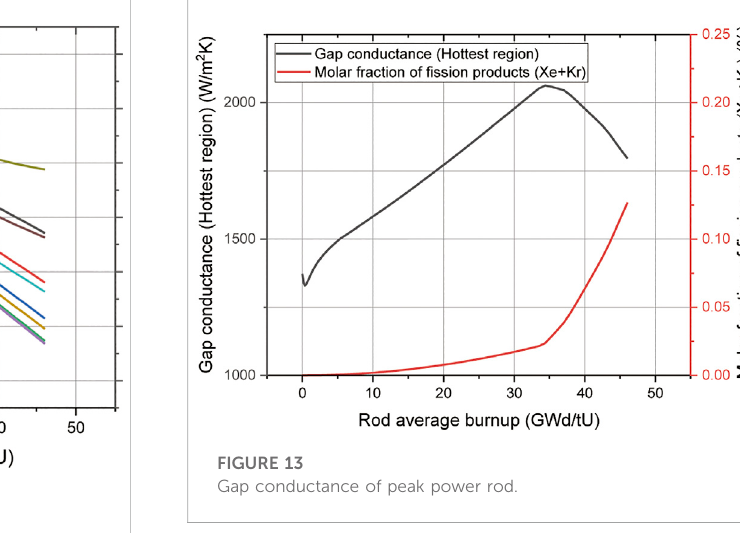
FIGURE 11 Pro fi le of gap width evolution.